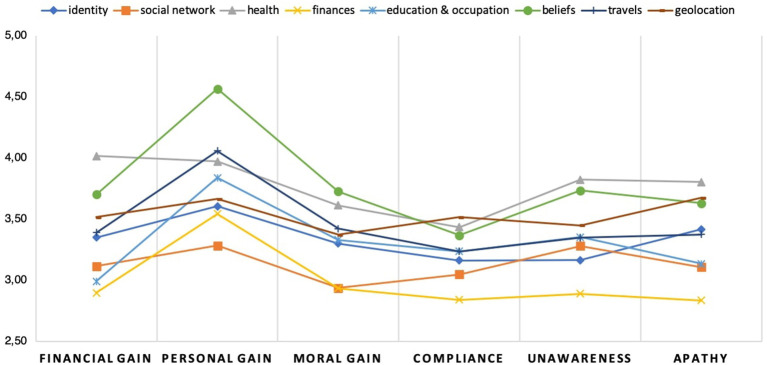
Users' reported cognitive and motivational biases for each scenario (item average).